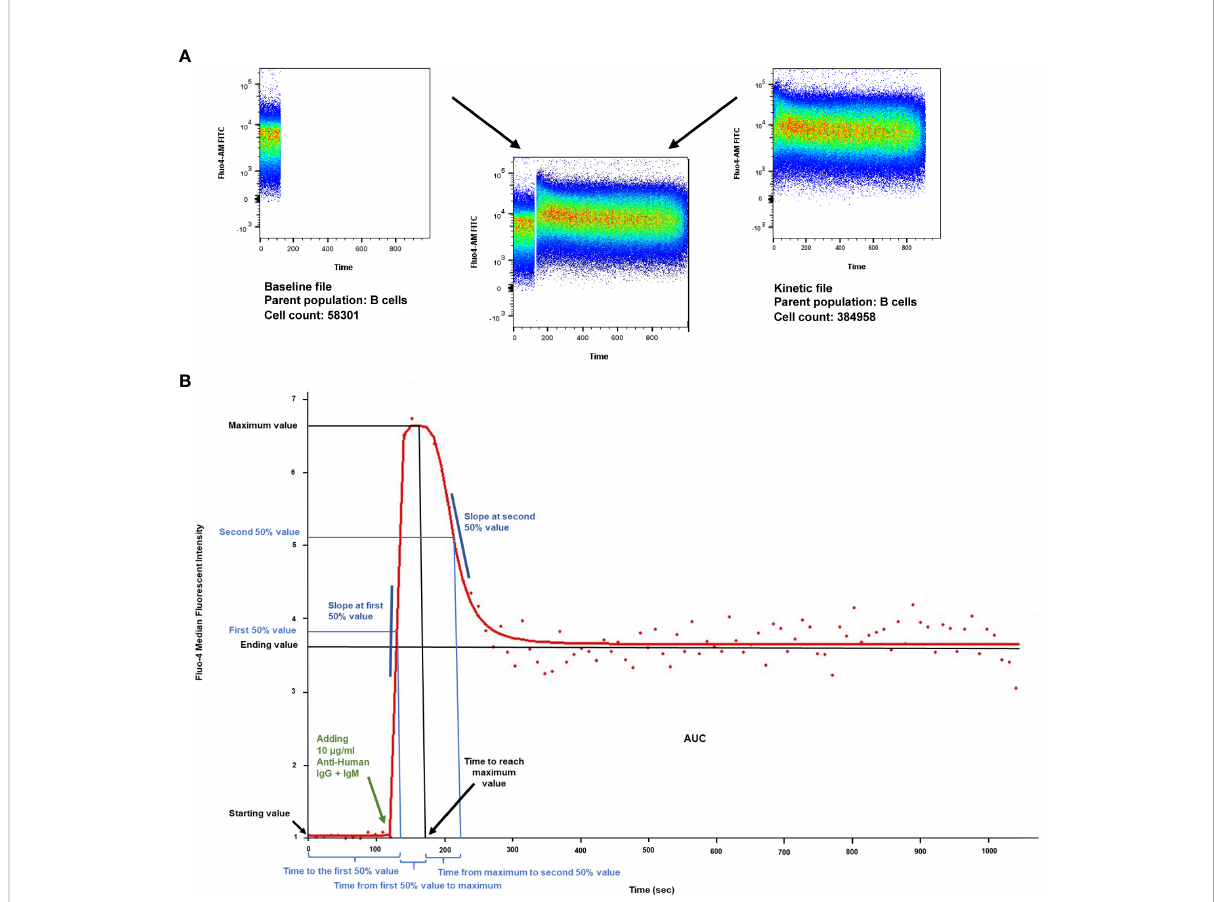
FIGURE 1 Calcium fl ux kinetic parameters. (A) Density plot of intracellular Ca 2+ mobilization in human B cells in response to anti-IgG+M antibody stimulation after labeling with Fluo4- AM (analyzed by FlowJo v10.7.1). X axis: time, Y axis: Fluo4-AM (FITC). Unstimulated controls were acquired for the fi rst 120 seconds for baseline, then B lymphocytes were activated by crosslinking the B cell receptor with 10 µg/ml F(ab ’ ) 2 Fragment Af fi niPure Goat Anti-Human IgG + IgM (H+L). Activated samples were recorded for 15 minutes (900 s) in a kinetic manner. (B) Parameters of the dlogist+ (Double-logistic) kinetic function calculated by FacsKin. Example of a Ca 2+ fl ux kinetic curve after anti-IgG+M activation. X axis: time, Y axis: relative parameter value: standardized based on the Fluo4- AM MFI (median fl uorescent intensity). The kinetic curve is created based on the median values of the gated population. The biologically relevant parameters are the following: starting value, calculated as the limit of the function at - ∞ (minus in fi nity) (standardized to 1); time to the fi rst 50% value (s); slope at fi rst 50% value, which is always positive and de fi nes how much the intensity changes during 1 second (unit: int/s where int is the unit of the vertical axis); time from fi rst 50% to maximum value (s), time to reach maximum value (s), maximum value (relative value); time from maximum to second 50% value (s); slope at second 50% value, always negative (unit: int/s); ending value, calculated as the limit of the function at + ∞ (positive in fi nity), AUC: the area under curve from time point 0 to 1020 s (manually set to actual time of